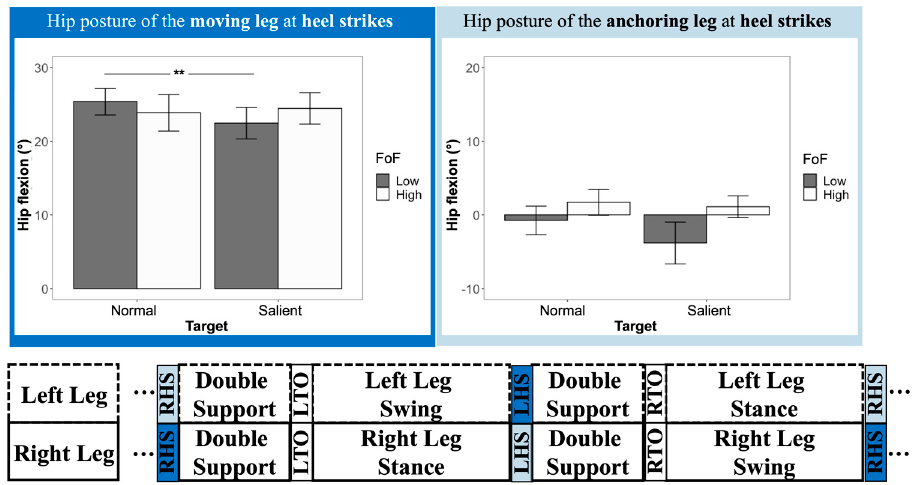
Figure 6. Hip flexion of the moving leg (dark blue) and the anchoring leg (light blue) at heel strikes. The double-asterisk symbol (**) was used to indicate a significant difference with an alpha level of 0.01.